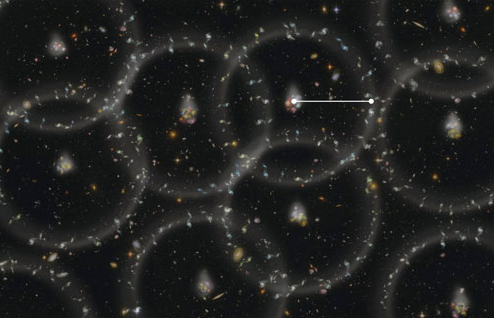
Figure 6. A cartoon produced by the BOSS project showing the spheres of baryons around the initial dark matter clumps. Adapted from: